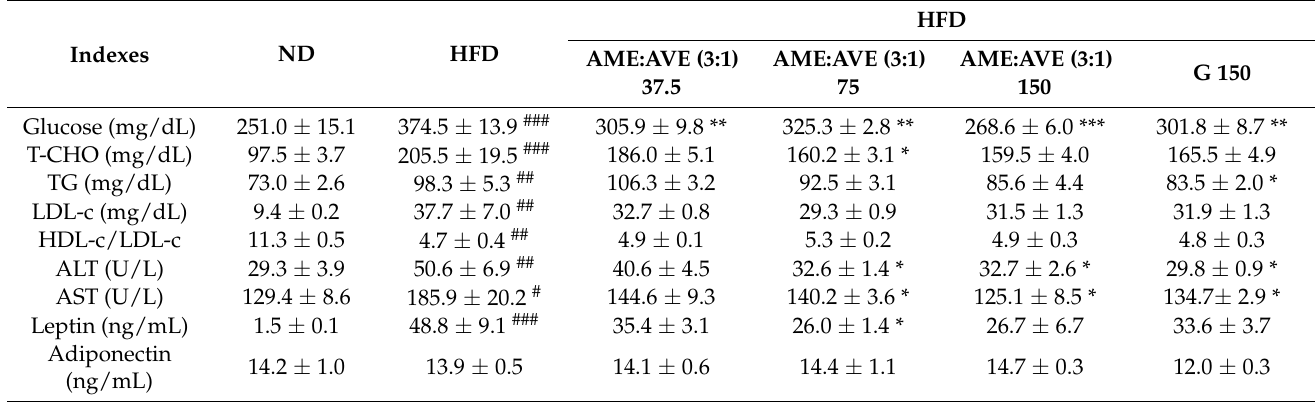
Table 1. Effects of Atractylodes macrocephala and Amomum villosum extracts (3:1) on plasma biochemical levels in high-fat diet-induced obesity in mice.